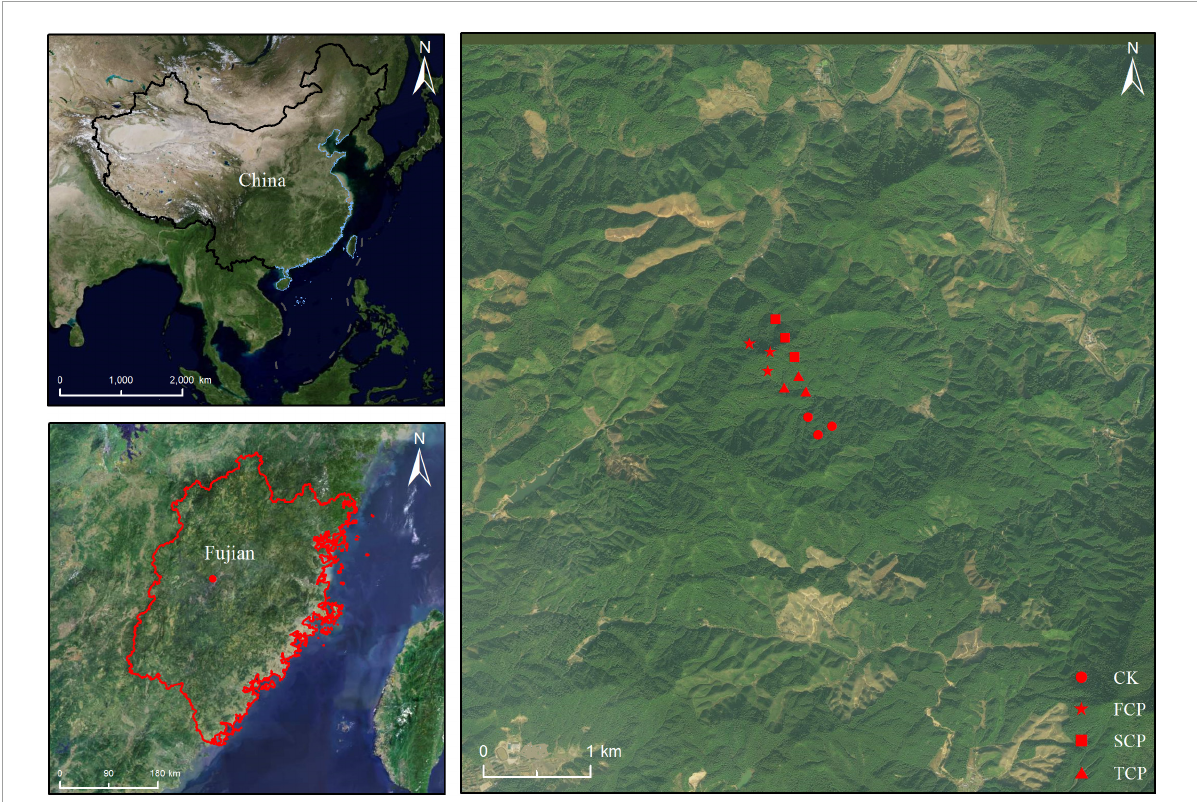
FIGURE1 Location of soil sampling site with varying generations at the Wangtai Town, Nanping City, Fujian Province, China. CK, Nanmu plantation; FCP, first-generation plantation; SCP, second-generation plantation; TCP, third-generation